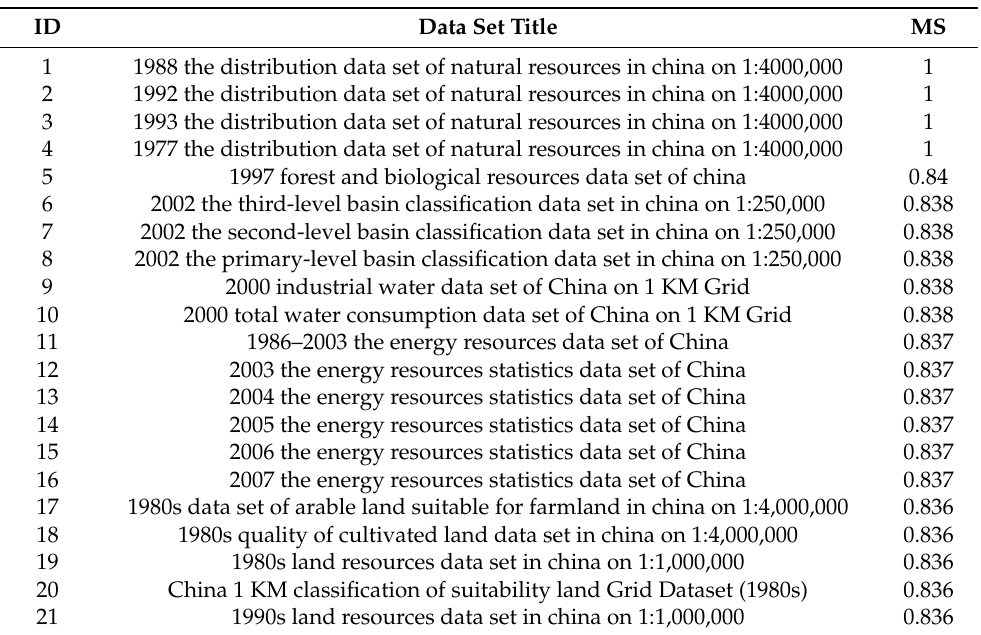
Table 7. Retrieval results of semantic retrieval techniques based on TLRM in 7169 data sets of